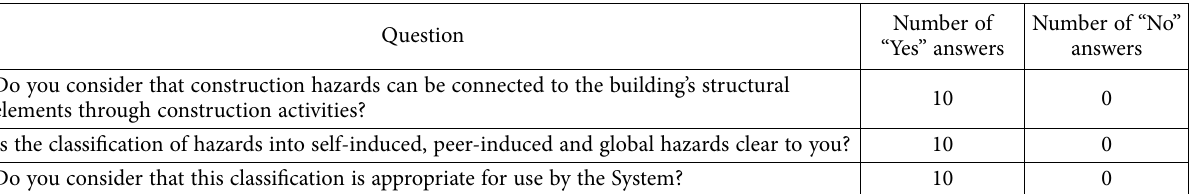
Table 3. Results of the validation